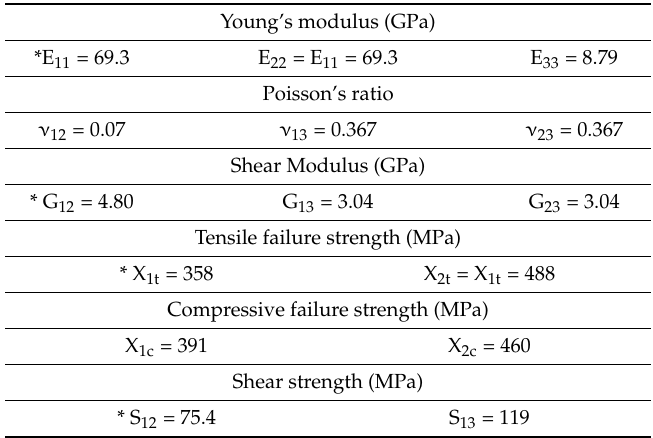
Table 3. Plain weave carbon fiber reinforced polymer (CFRP) material